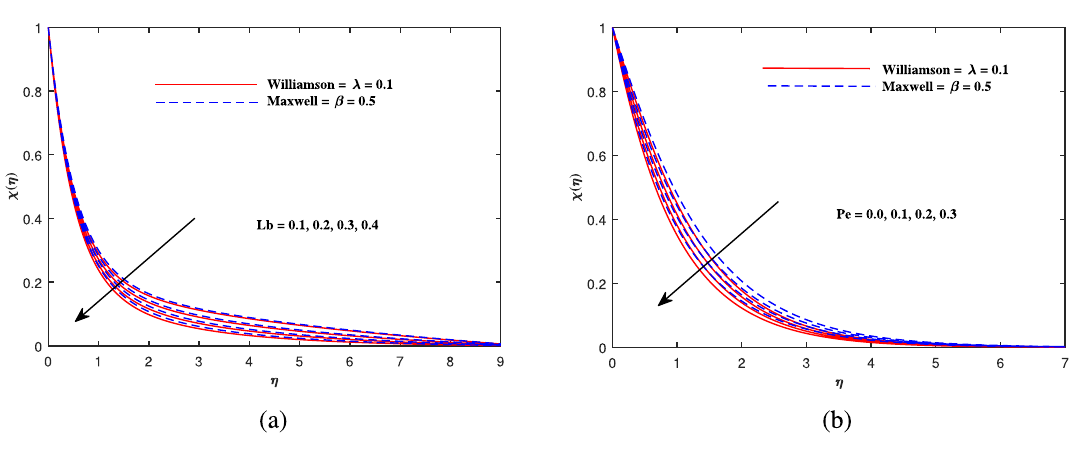
Figure 9. Motile density χ(η) fluctuation with ( a ) Lb and ( b ) Pe